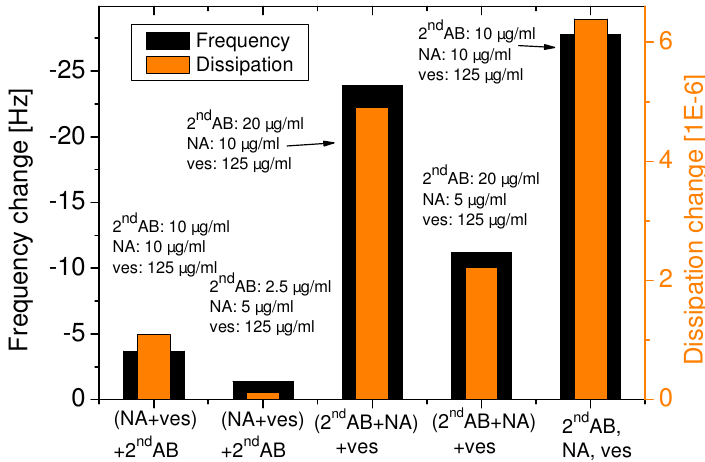
Figure 5. Frequency and dissipation change upon injection of NA, 2 nd AB and vesicles as a function of mixing order and concentrations. For the first two measurements (from left to right) prior to injection neutravidin (NA) was first mixed with the vesicles and 10 minutes later the secondary antibody (2 nd AB) was added. In the next two experiments, prior to injection NA and the 2 nd AB were mixed before the addition of the vesicles. The right bar shows the control where the injection was performed in three individual